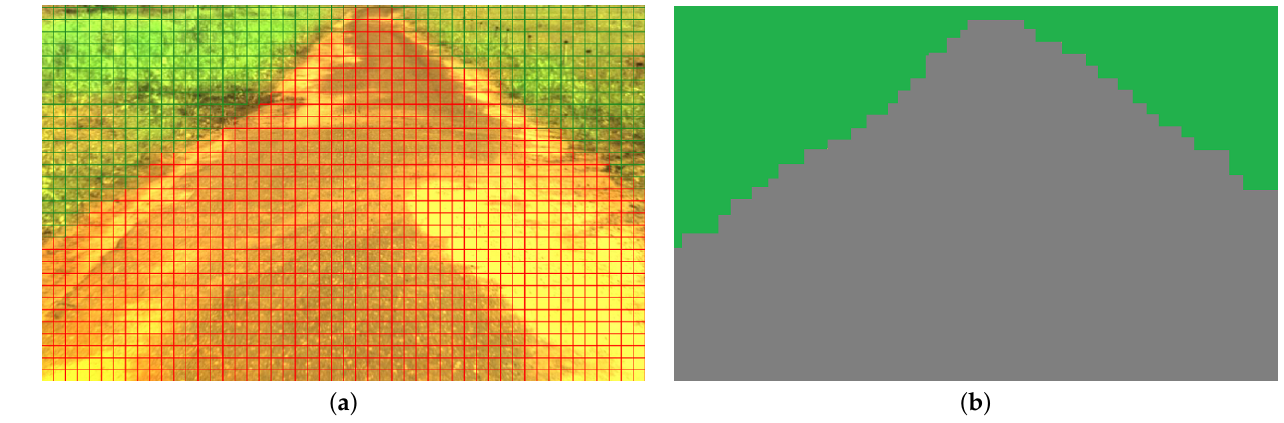
Figure 10. The segmentation results, ( a ) original image, ( b ) image after